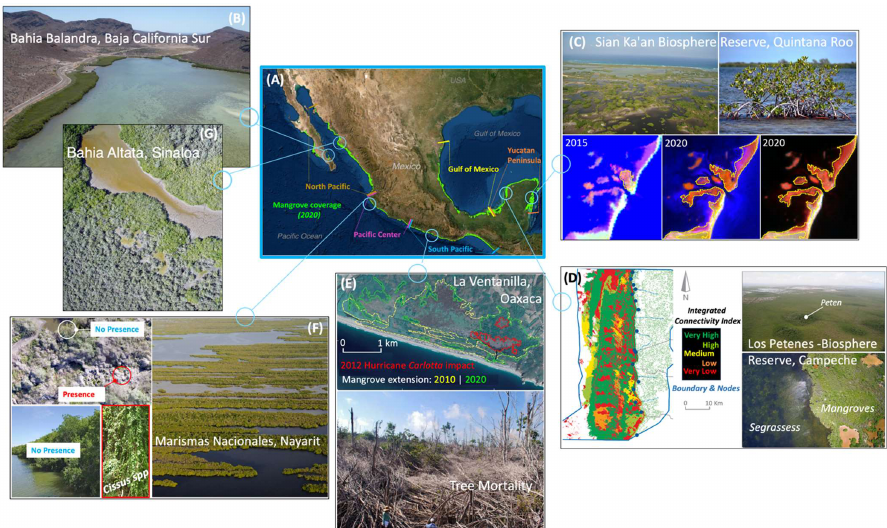
Figure 7. Selected study cases in different locations and Mexican states along the Pacific and Gulf of Mexico coasts as part of the SMMM; Map sources: Esri, DigitalGlobe, GeoEye, Earthstar Ge- ographics, CNES/Airbus DS, USDA, USGS, AeroGRID,IGN, and the GIS User Community ( A ), which is integrated by the North, Center and South Pacific regions and the Yucatan and Gulf of Mexico regions; the boundaries among these regions are marked by perpendicular colored lines. ( B ) mangrove distribution in semi-arid regions, Bahía Balandra, Baja California Sur (photo credit: C. Troche); ( C ) spatial analysis of scrub mangrove forests, Reserva de la Biosfera Sian Ka’an, Quintana Roo (photo credits: left, O. Ortiz; right, A. Alcántara); the second row panel shows images depicting different bands combinations (left to right): B3, B4, B2 (2015, Spot, CNES); B8, B11, B4 (2020): ESA, Copernicus Space Component); B8, B11, B12 (2020): ESA, Copernicus Space Component); ( D ) Con- nectivity analysis between mangroves and sea grasses in Reserva de la Biosfera Los Peténes, Cam- peche (photo credits: above, M.T. Rodríguez; below J. Díaz; ( E ) Mangrove mortality caused by hur- ricane “ Carlotta ” in La Ventanilla, Oaxaca (photo credit: C. Tovilla); ( F ) phenological analysis of the species Rhizophora mangle impacted by invasive species (presence; Cissus spp.) in Marismas Nacion- ales, Nayarit (photo credits: upper and below left: A. Alcántara, right E. Villeda; Cissus spp. photo source: Forest & Kim Starr: http://www.starrenvironmental.com/imageusepolicy/, accessed on 17 March 2022; ( G ) Mangrove distribution along the semiarid coastal region of Bahía Altata, Sinaloa (photo credit: A. Segovia). See results and discussion section for each study description and objec-